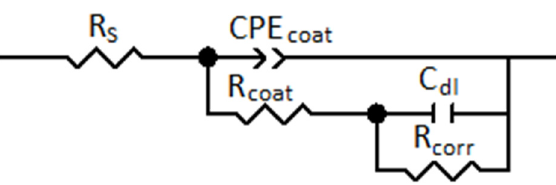
Figure 4. Equivalent circuit for Faraday and electrode impedances, where R s is the electrolyte resistance, CPE coat is the constant phase element, R coat is the ohmic coating resistance, C dl is the double layer capacity at the metal/coating surface and R corr is the chemical reaction resistance.